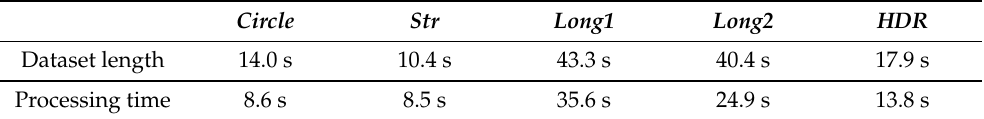
Table 2. Processing time in seconds (s) for the proposed